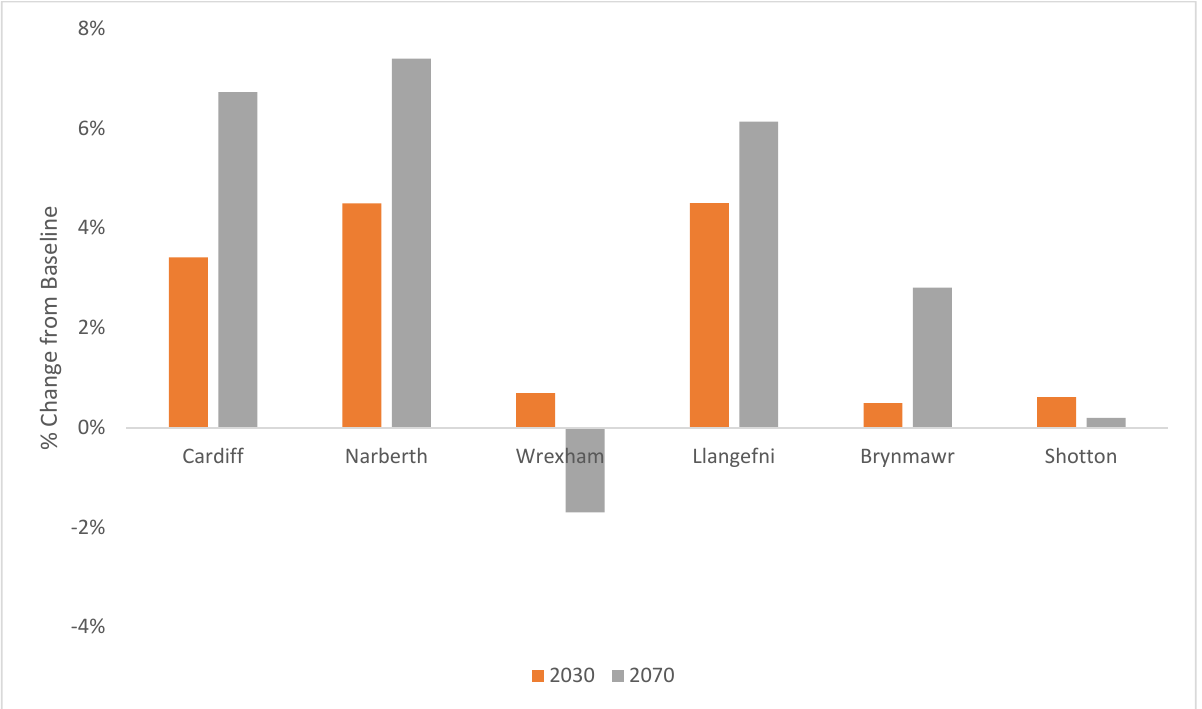
Figure 10. Change in average annual precipitation for six locations throughout Wales for 2030 and 2070 .